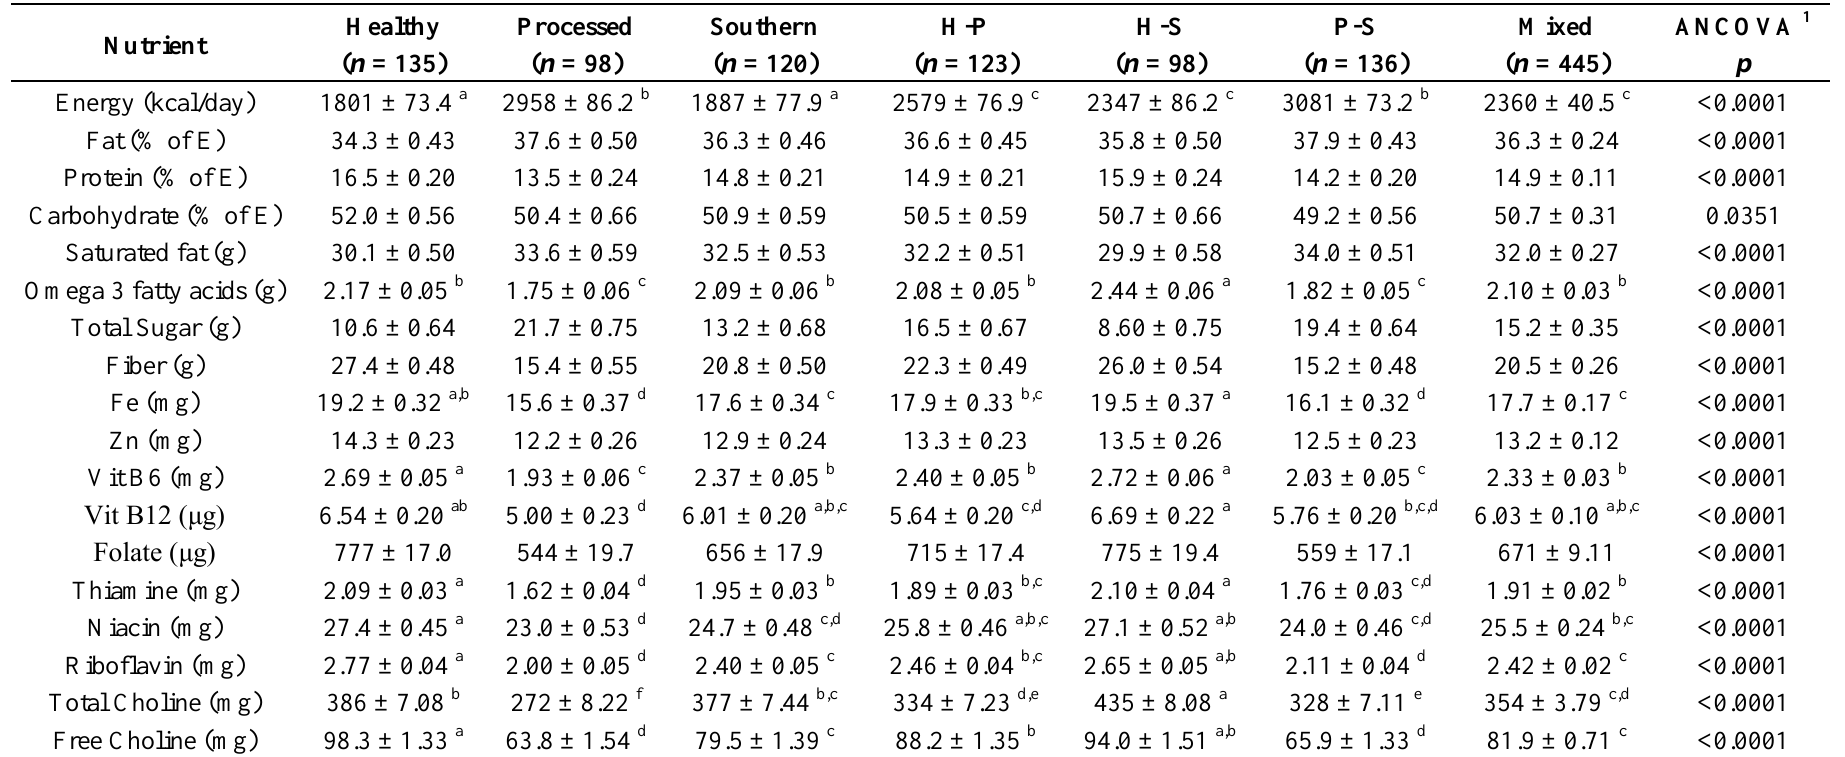
Table 4. Daily intake of total energy, macro- and energy adjusted micronutrients in the seven dietary